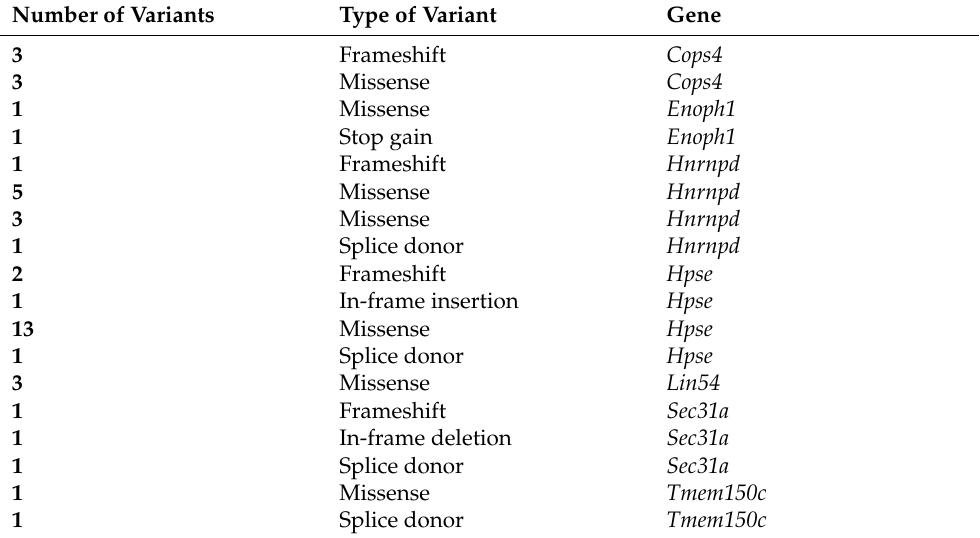
Table 3. The Chr5:100.164-100.895Mb QTL for cocaine related phenotypes contains predicted delete- rious variants in 8 genes.